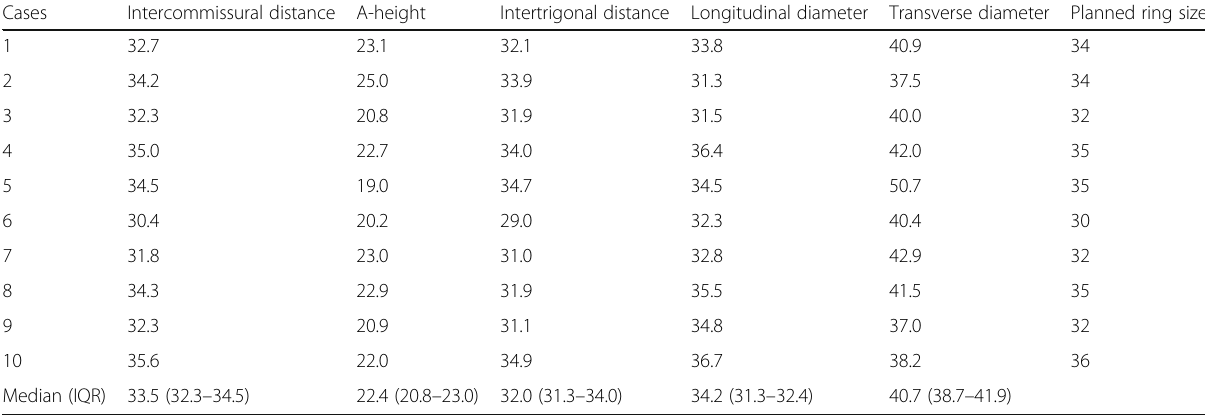
Table 1 Detailed mitral measurements and the planned ring sizes by the anesthesiologist Cases Intercommissural distance A-height